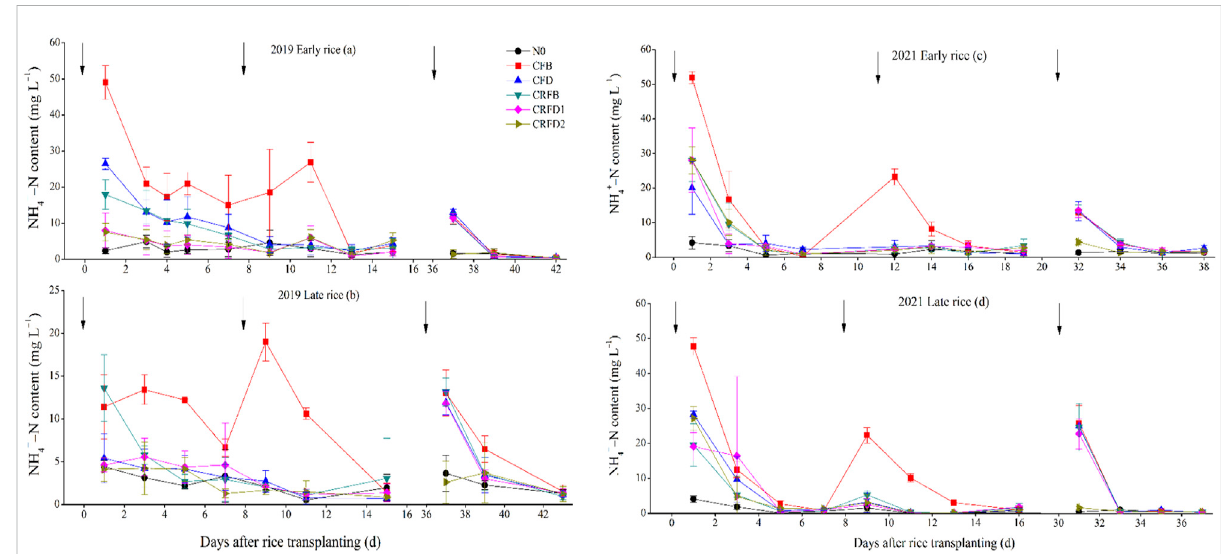
FIGURE 3 The NH 4 + – N concentrations in surface water for early (A,C) and late rice (B,D) under different treatments in 2019 (A,B) and 2021 (C,D) . Values arepresentedasthemean±standarddeviation( n =3).ThearrowrepresentsthetimingofNfertilizerapplication,followingbasal,tilleringandpanicle fertilizations, respectively. N0: no N fertilizer; CFB: compound fertilizer broadcasting; CFD: compound fertilizer side-deep placement; CRFB: controlled-releaseNfertilizerbroadcasting;CRFD1:controlled-releaseNfertilizerside-deepplacement;CRFD2:controlled-releaseNfertilizer side-deep placement, one-time